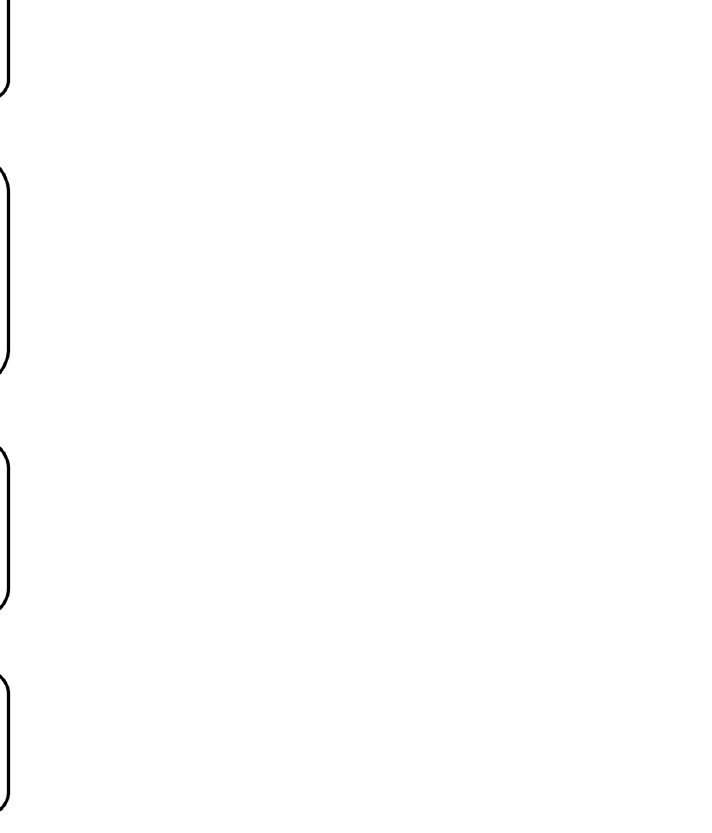
Figure 1. Pipeline of SNP detection, selection and final choice with all filters applied to design the Almond SNP array. (TE: Transposon Element, NA: missing data, MAF: Minor Allele Frequency).